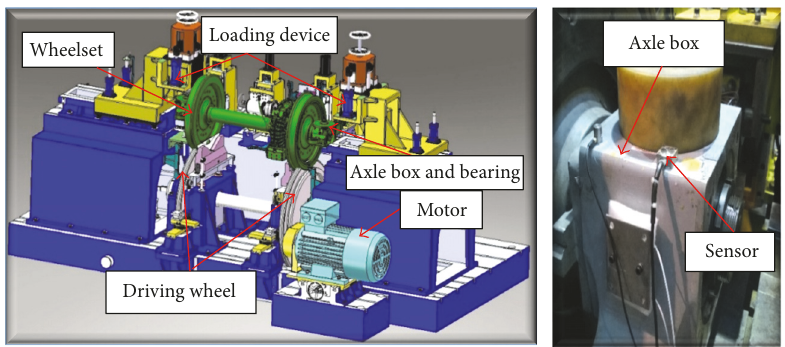
Figure 7: Photos of the test bench and measurement sensor.